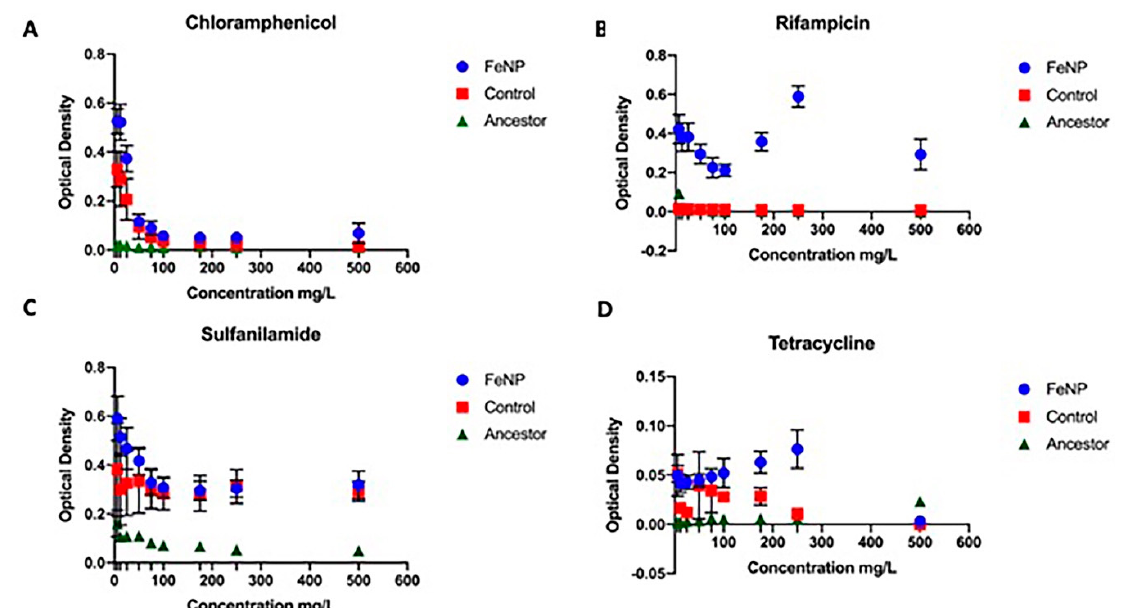
Figure 3. The mean and SE of 24 h growth for FeNP, Control, and Ancestral populations in increasing concentration of antibiotics are shown. The FeNP populations showed superior growth compared to controls and ancestors for chloram- phenicol at 25, 60 mg/L ( A ); rifampicin ( B ) from 25–500 mg/l; sulfanilamide ( C ) from 50–75 mg/L; and tetracycline ( D ) from 75–250 mg/L. The ancestor showed inferior growth to the FeNPs and controls at all concentrations.